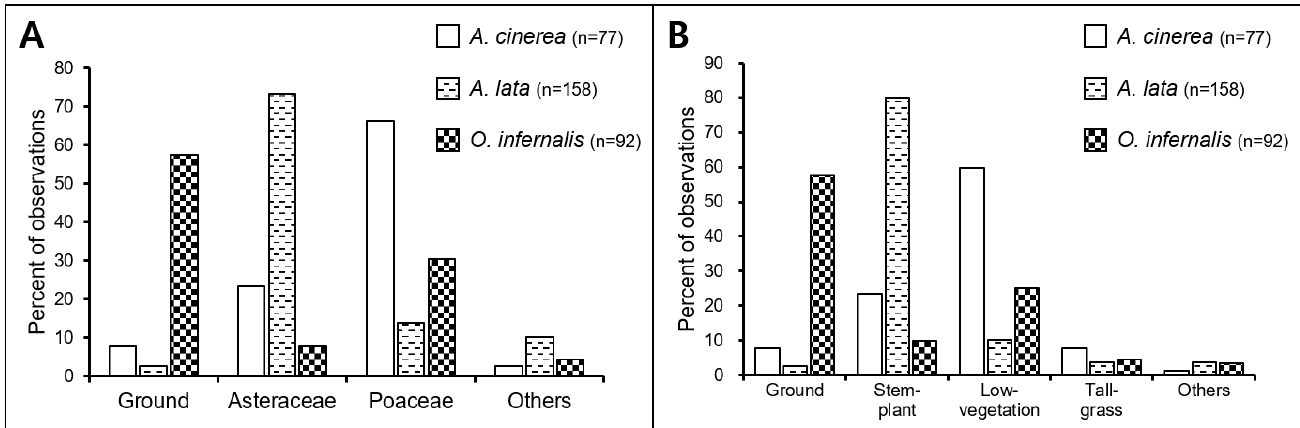
Fig. 1. The use of different types of substrates by the three grasshopper species. A. Substrates divided according to taxonomy; B. Substrates divided according to vegetation structure.